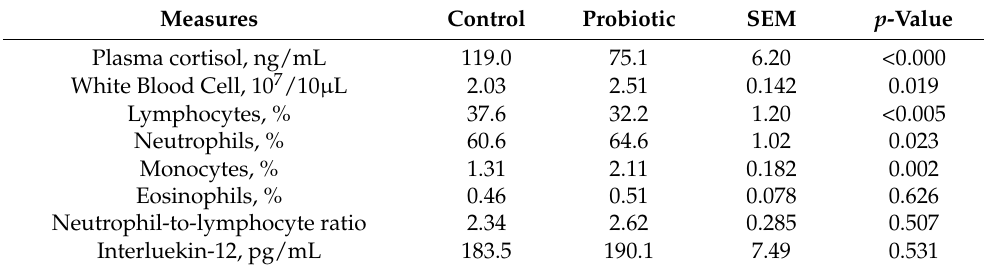
Table 2. Prenatal maternal gestational treatment effects on the progeny mean plasma cortisol, white blood cell counts, leukocyte differentials, neutrophil-to-lymphocyte ratio, and interleukin-12 at 24 h post-birth 1,2 .